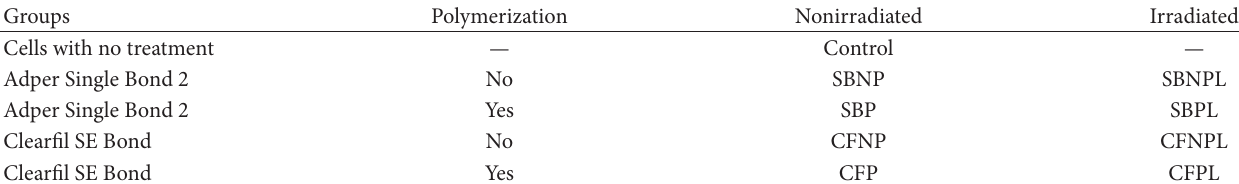
Table 2: Experimental groups.